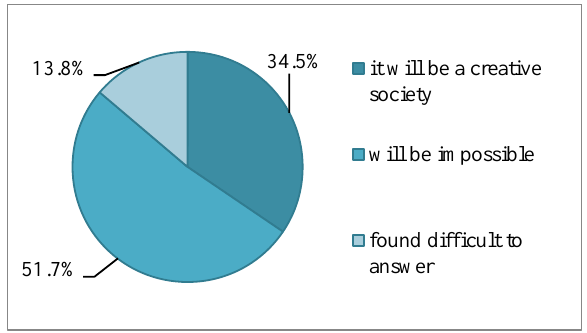
Fig. 2. The opinion of the respondents about the possibility of the existence of a humanistic